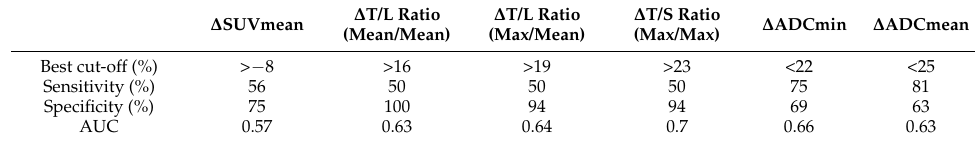
had significantly longer HPFS (Figure 7). Table 7. ROC analysis of SUV and ADC for predicting HPFS < 24 months.